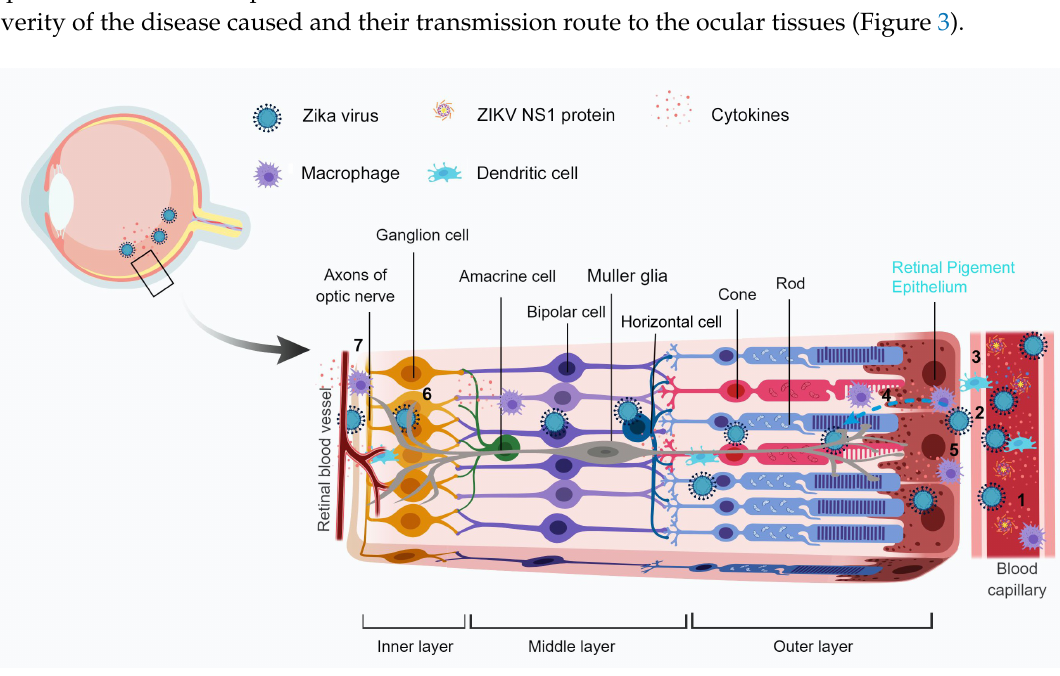
Figure 3. Probable mechanisms for the breach of blood-retinal barriers by ZIKV. Upon infection and peak viremia, there is an increased circulation of Zika virus, ZIKV NS1 protein, and immune cells in the blood (1). The virus in the retinal blood capillaries infect the endothelial lining (2) and the immune cells reach the site of infection/inflammation by diapedesis through the capillaries (3). It is followed by infection of RPE, the cell lining the outer BRB, resulting in chorioretinal atrophy. The viral infections might cause a BRB weakening by decreasing intercellular junction integrity. Being a neurotrophic virus, at later stages ZIKV can infect retinal Muller glia or neurons inside of the eye (4). The complications are worsened with the involvement of immune cells which get activated upon infection and release a “cytokine storm” as an antiviral response which damages the host cells by altering the barrier integrity (5). The virus along with the circulating immune cells can cross the inner BRB (retinal blood vessels) and infect neuronal cells such as ganglion cells (6, 7). The Image has been created with BioRender